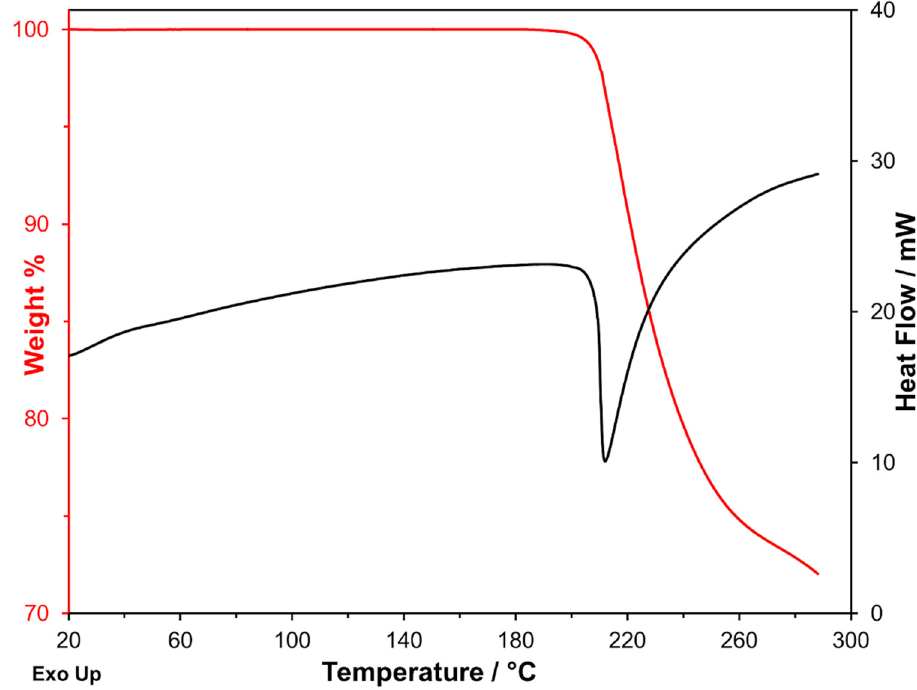
Figure 2. Simultaneous DSC–TGA curves recorded on one of the production batches at 10 K · min − 1 under nitrogen flow.